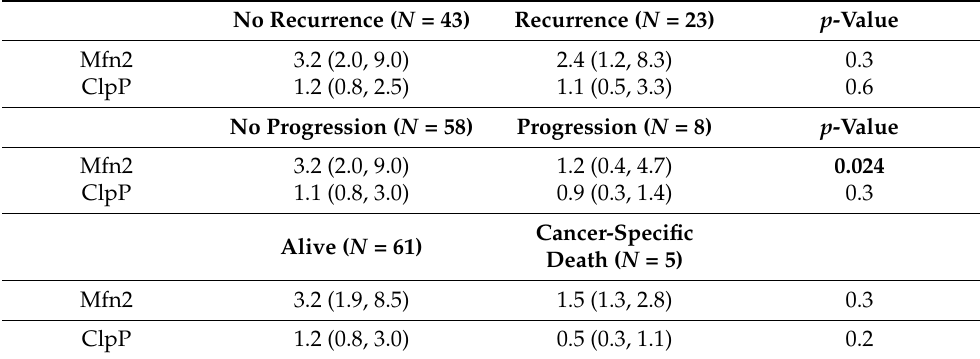
Table 2. Lesional Mfn2 and ClpP expression levels according to disease recurrence, disease progres- sion, and cancer-specific death.